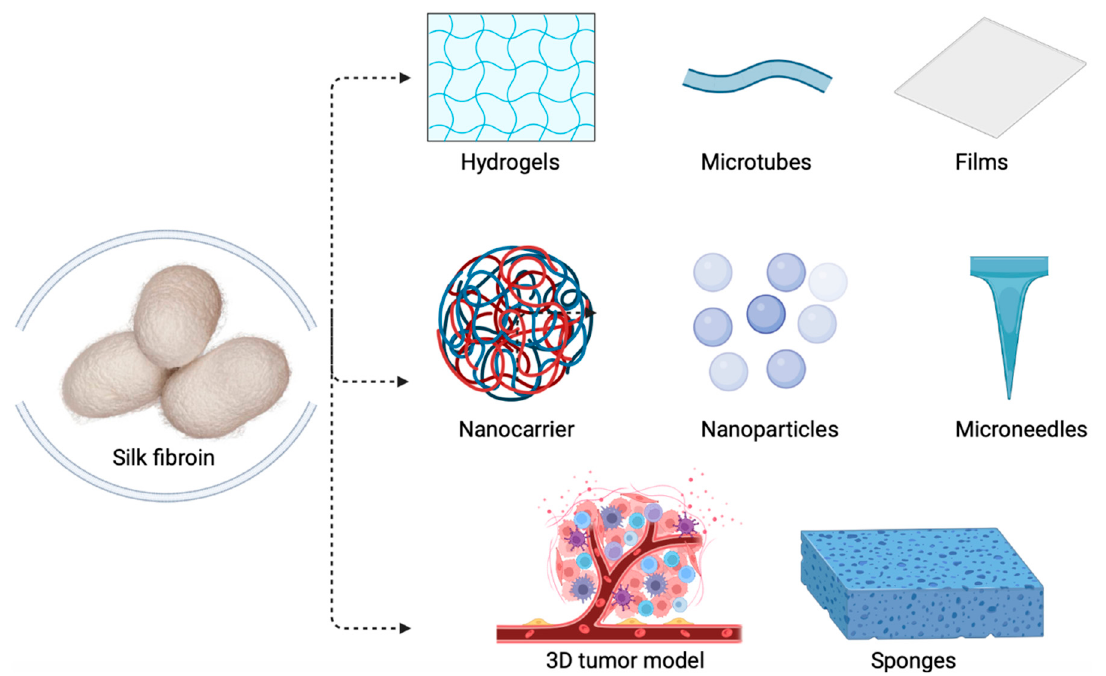
Figure 2. Silk fibroin-based biomaterials (Created with BioRender.com, accessed on 23 November 2022)).